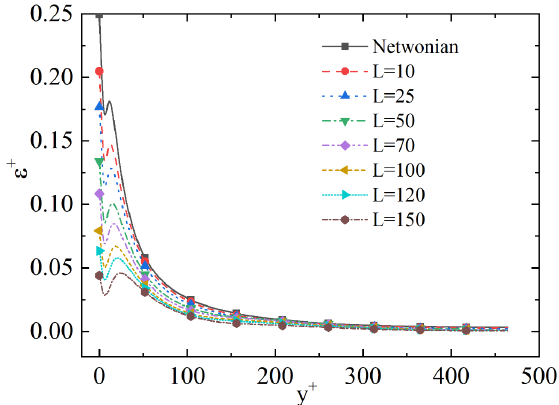
Figure 12. Dimensionless turbulent dissipation rate ( ε + ) of different maximum extensibility of the polymer molecule ( L ).